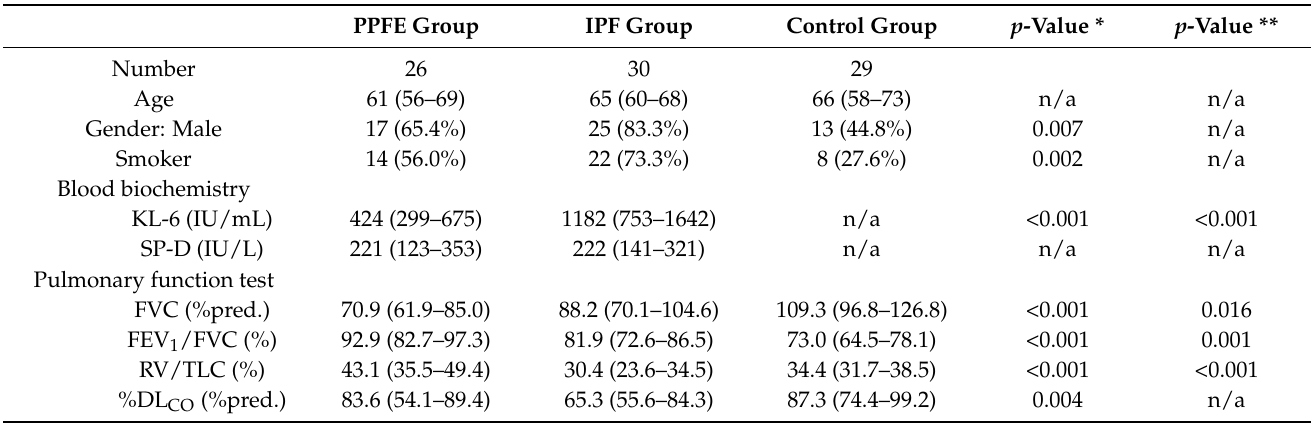
Table 1. Patient